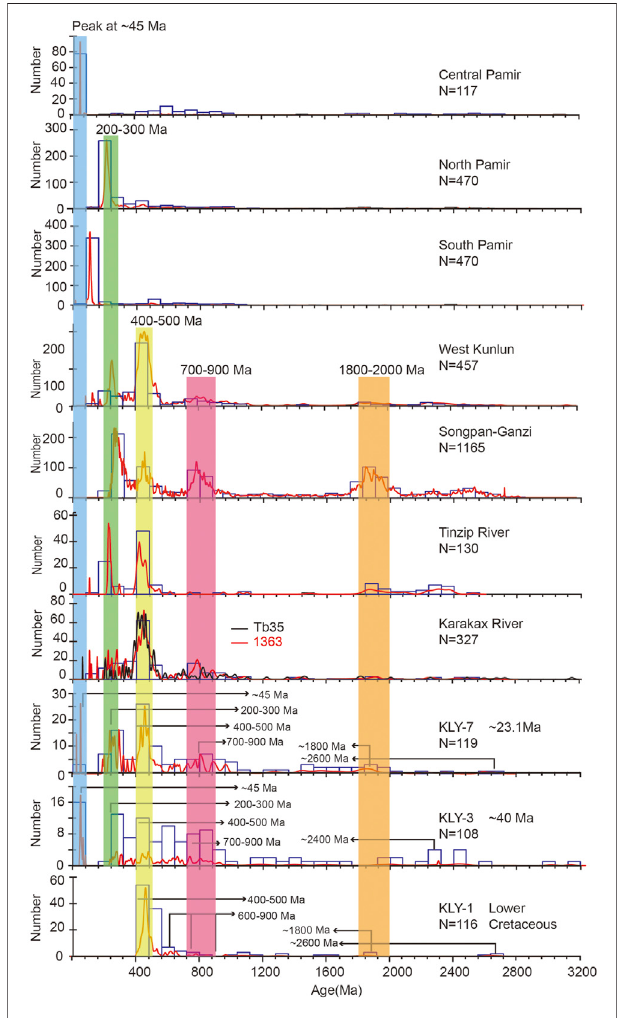
FIGURE 6 | Detrital zircon U/Pb ages from the Keliyang section in the SW Tarim Basin and potential source correlation. The North Pamir provenance is dominated by a 200 – 300 Ma peak (Carrapa et al., 2014; Blayney et al., 2016; Rittner et al., 2016). The Central Pamir provenance is dominated by a ∼ 45 Ma peak (Lukens et al., 2012). The South Pamir provenance is dominated by a peak of ∼ 100 Ma (Blayney et al., 2016). The West Kunlun provenance has two peaks, at ∼ 200 – 300 Ma and 400 – 500 Ma, with two less prominent peaks at ∼ 800 and ∼ 1800 Ma (Blayney et al., 2016). The Songpan-Ganzi provenance has four peaks, at ∼ 200 – 300, ∼ 400 – 500, ∼ 700 – 900 and ∼ 1800 – 2000 Ma (Ding et al., 2013). The modern Tinzip River (1,344) provenancehas adouble peak at 200 – 300and 400 – 500 Ma (Blayney et al.,2016).The modern Karakax Rivercatchment(1,363, Tb35) provenance has a peak at 400 – 500 Ma (Blayney et al., 2016; Rittner et al., 2016). N is the number of Concordia zircons. The shaded bars highlight the dominant zircon U/Pb age ranges.